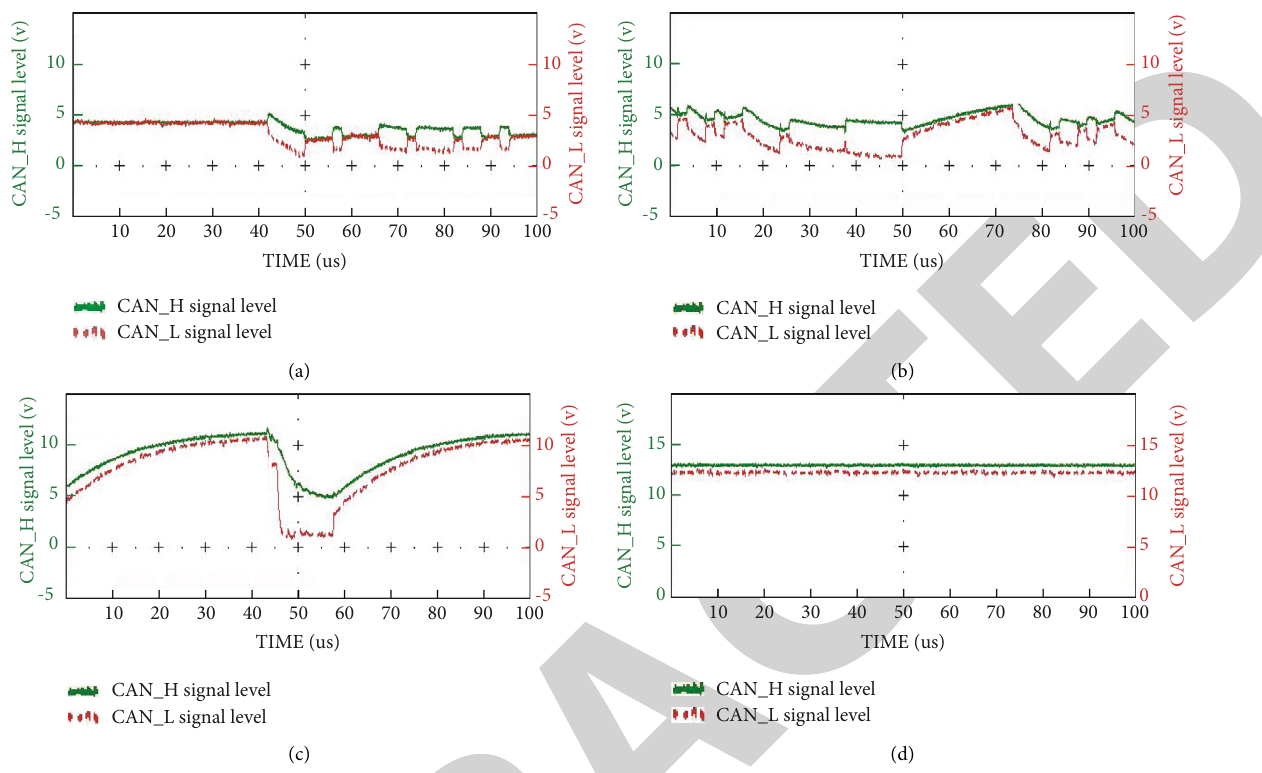
Figure 4: Signal waveform of PT-CAN_H to battery loaded with different resistances. (a) PT-CAN_H load resistance to battery with 2.5k Ω . (b) PT-CAN_H load resistance to battery with 500 Ω . (c) PT-CAN_H load resistance to battery with 150 Ω . (d) PT-CAN_H load resistance to battery with 0 Ω